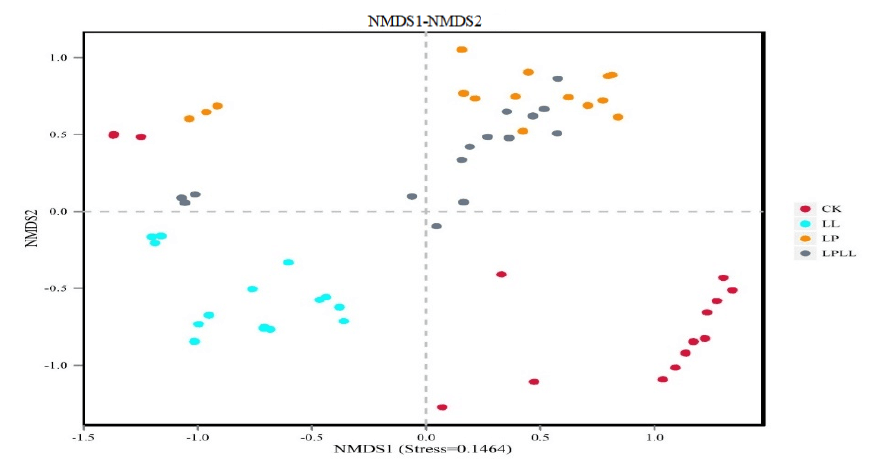
Figure 9. NMDS of fermented sugarcane juice. CK: fresh sugarcane juice; LL: sugarcane juice with added HNK10; LP: sugarcane juice added with HNK21; LPLL: sugarcane juice treated with HNK10 + HNK21 was